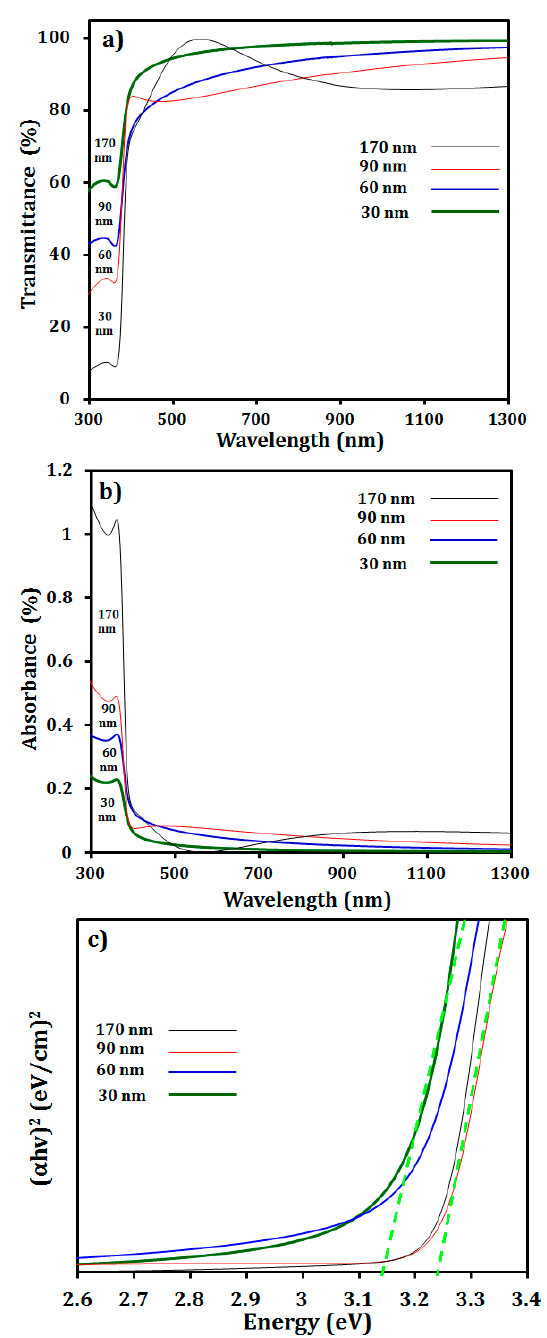
Figure 10. Optical properties of the SLG / i-ZnO thin film measured by UV-VIS spectroscopy: ( a ) transmittance, ( b ) absorbance, and ( c ) optical band gap.